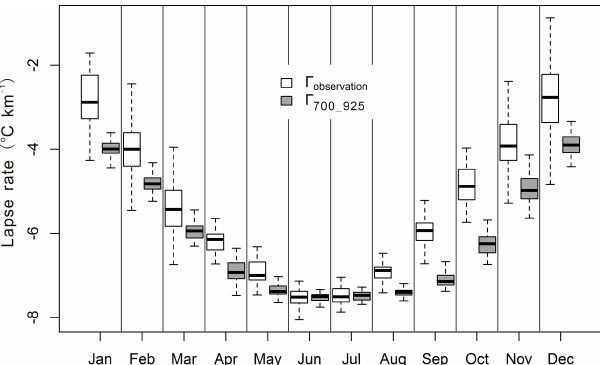
Figure 4. Box plots of monthly lapse rates for observation and ERA-Interim ( (cid:48) 700_925 ). Thick horizontal lines in boxes show the median values. Boxes indicate the inner-quantile range (25% to 75%) and the whiskers show the full range of the values.